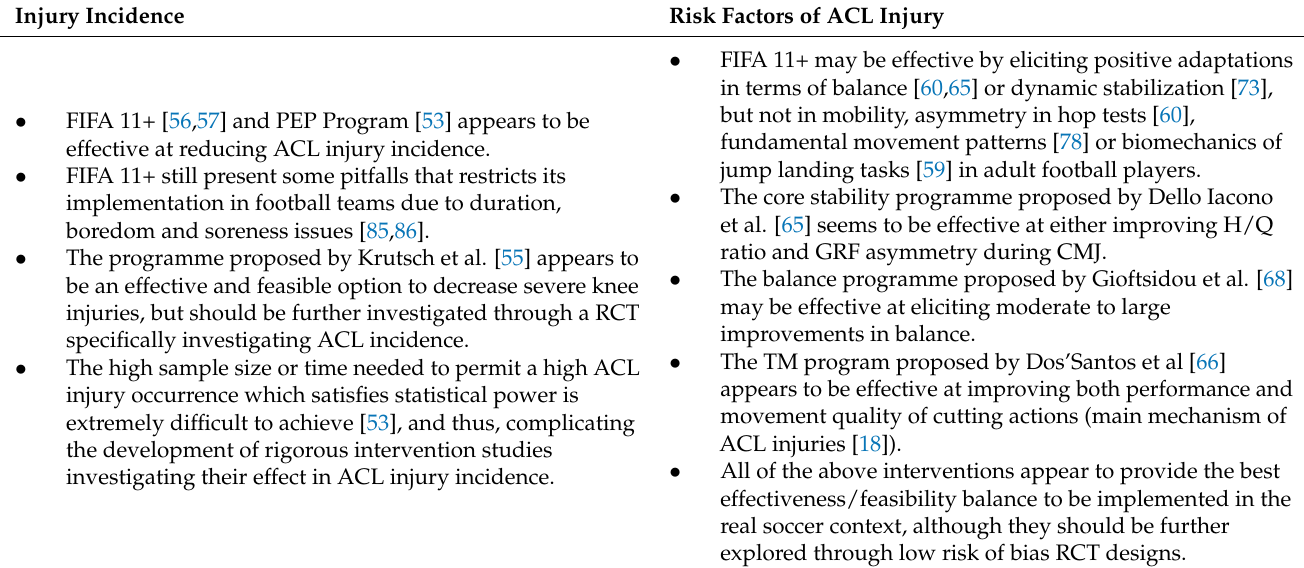
Table 5. Summary of evidence regarding the efficacy of exercise-based interventions on ACL injury incidence and risk factors of ACL injury coming from randomized-controlled trials and nonrandomized studies. Injury Incidence Risk Factors of ACL